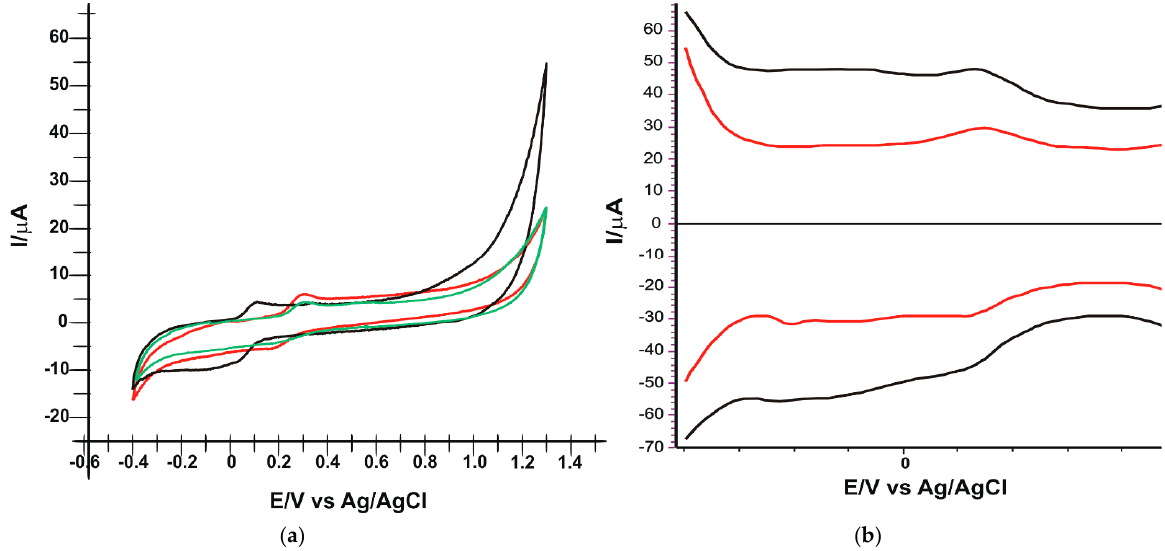
Figure 4. ( a ) Cyclic voltammograms of SPE/SWCNT (green line), SPE/SWCNT/Tyr (black line) and SPE/SWCNT-Lac (red line) in PBS solution 10 − 1 M (pH 7.0) containing 10 − 4 M OLEU. Scan rate: 0.1 V×s − 1 . ( b ) Square wave voltammograms of SPE/SWCNT/Tyr (black line) and SPE/SWCNT-Lac (red line) in PBS solution 10 − 1 M (pH 7.0) containing 10 − 4 M OLEU (anodic scan-up and cathodic scan-down).